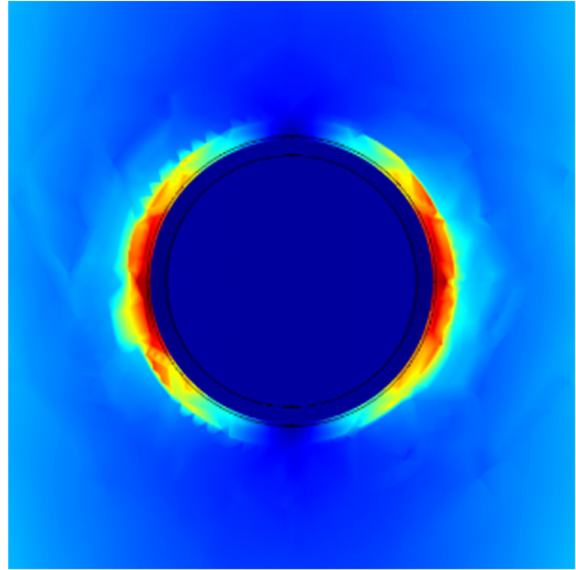
Figure 11. The distribution of electric field at the interface.